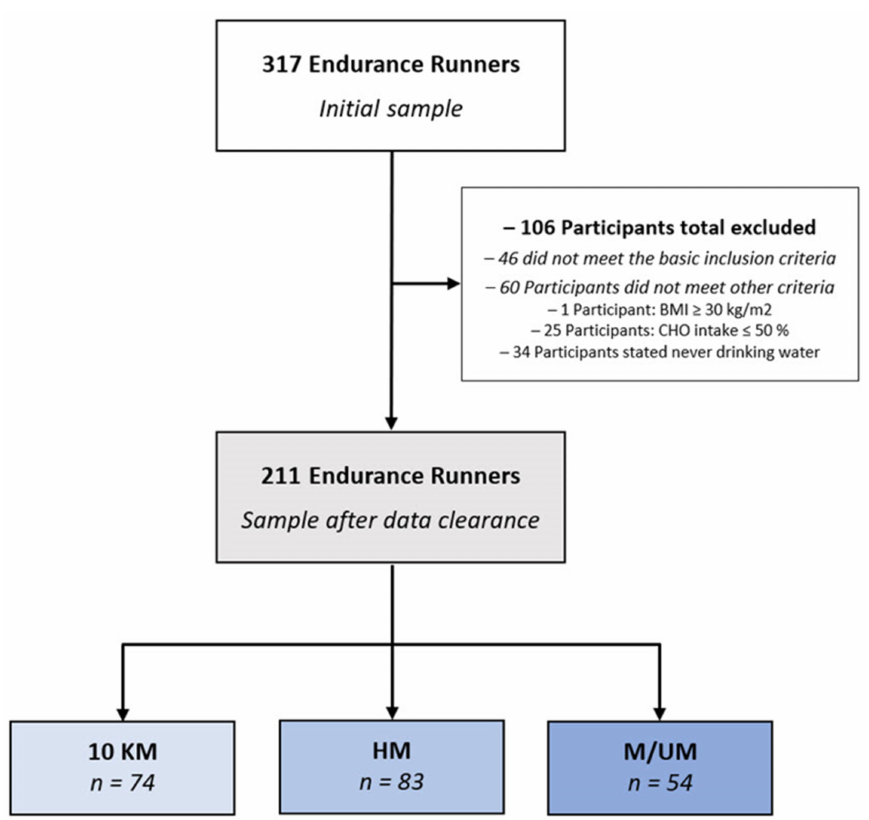
Figure 1. Participants’ enrollment and classifications by race distance. BMI—body mass index. CHO—charbohydrates. 10 KM—10-kilometers. HM—half-marathon. M/UM—marathon/ultra-